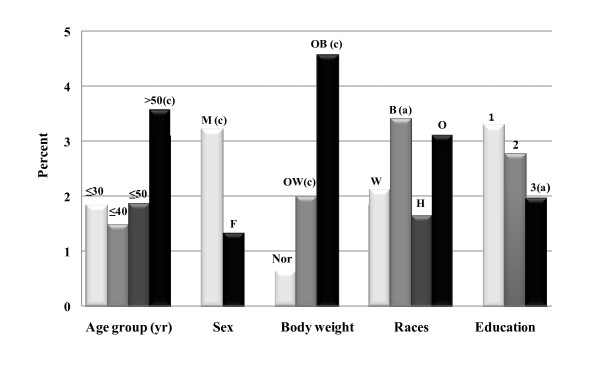
Hyperuricemia Rates by Demographics. For Sex, M = males (n = 4,385), F = females (n = 4,999); for Body weight, Nor = normal (n = 3,186), OW = over weight (n = 3,315), OB = obese (n = 2,893); for Races, W = Whites (n = 4,533), B = Blacks (n = 1,810), H = Hispanics (n = 2,766), O = Others (n = 275); and for education, 1 = under high school (n = 2,777), 2 = high school diploma (n = 2,223), 3 = above high school (n = 4,384). Compared to F, Age group ≤ 30, Nor, W, or education-1, letter (a) = p < 0.05, (b) = p < 0.01 and (c) = p < 0.001 with the adjustment as indicated in statistical analysis.